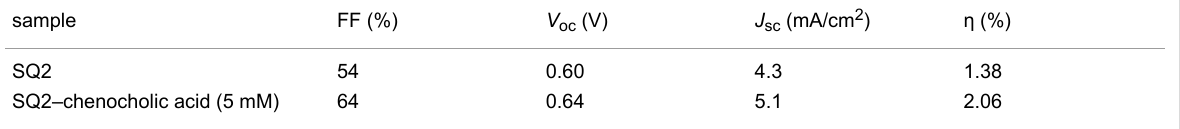
Table 4: Performances of SQ2 sensitized and a mixture of SQ2 and 5 mM chenodeoxycholic acid sensitized solar cells.